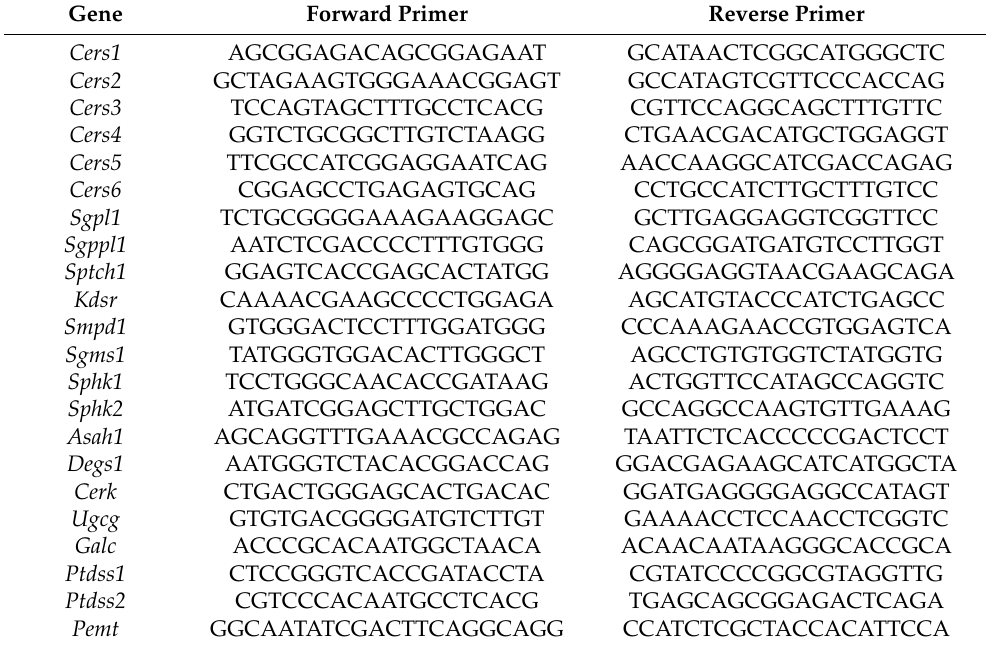
Table 1. Sequences of primers used in this